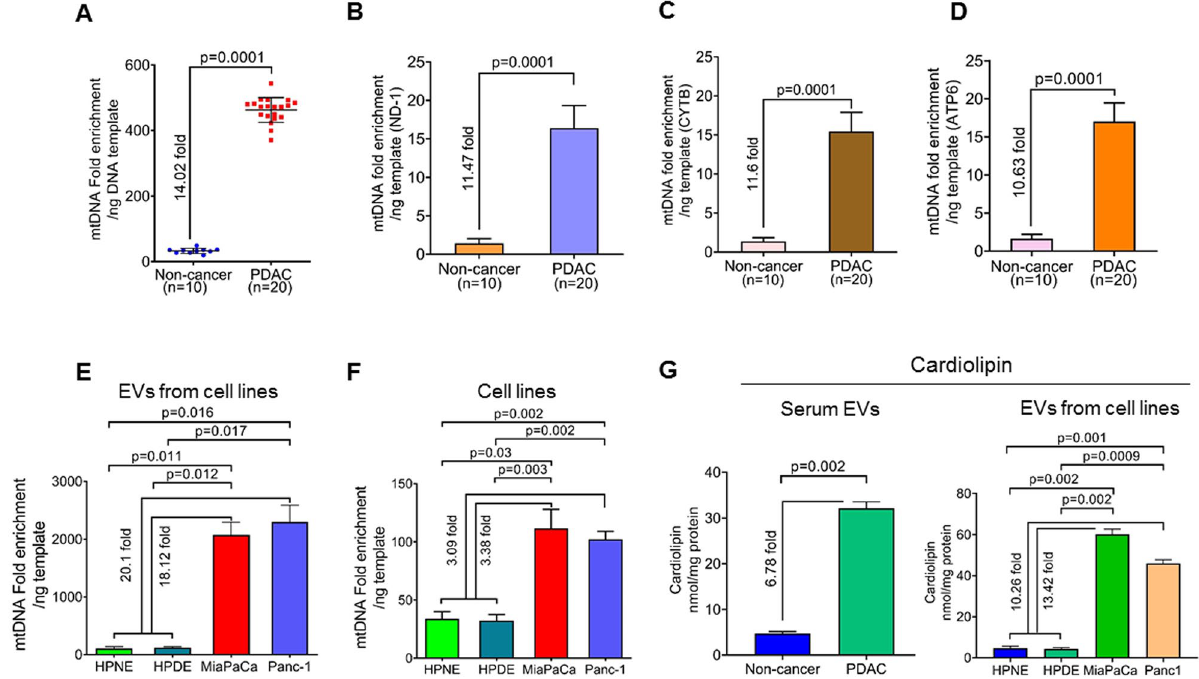
Figure 2. Determination of mitochondrial DNA enrichment in the extracellular vesicles. ( A ) MtDNA was amplified by mitochondrial whole genome amplification using an equal amount of total DNA. Subsequently, DNA amount was measured, and fold enrichment of DNA content was calculated. The data is presented as a fold-difference of mean mtDNA enrichment values ± SD. ( B – D ) Real-time PCR analysis was performed for mitochondrial genes, ND-1 , CYTB , and ATP6 , using an equal amount of EVs DNA templates from each subject. ( E ) EVs were collected from the culture supernatant of non-tumorigenic pancreatic epithelial (HPNE and HPDE), pancreatic cancer cell lines (MiaPaCa and Panc-1), and total DNA from EVs were isolated. Fold enrichment of DNA content was calculated following mitochondrial whole genome amplification, and